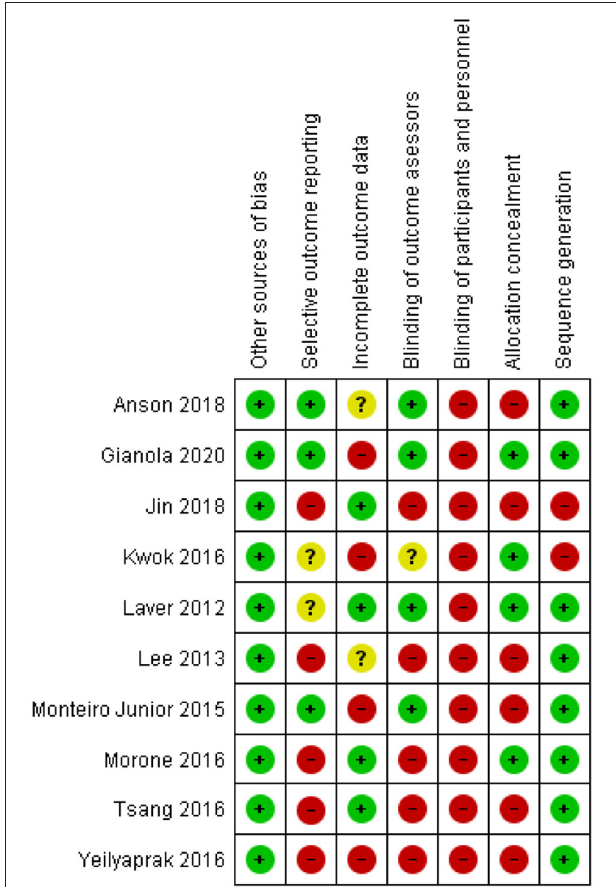
FIGURE 7 | Risk of bias (RoB) summary of included studies (only quantitative synthesis). Icon explanations: green "+",low risk of bias; red "-", high risk of bias; yellow "?", uncertain risk of